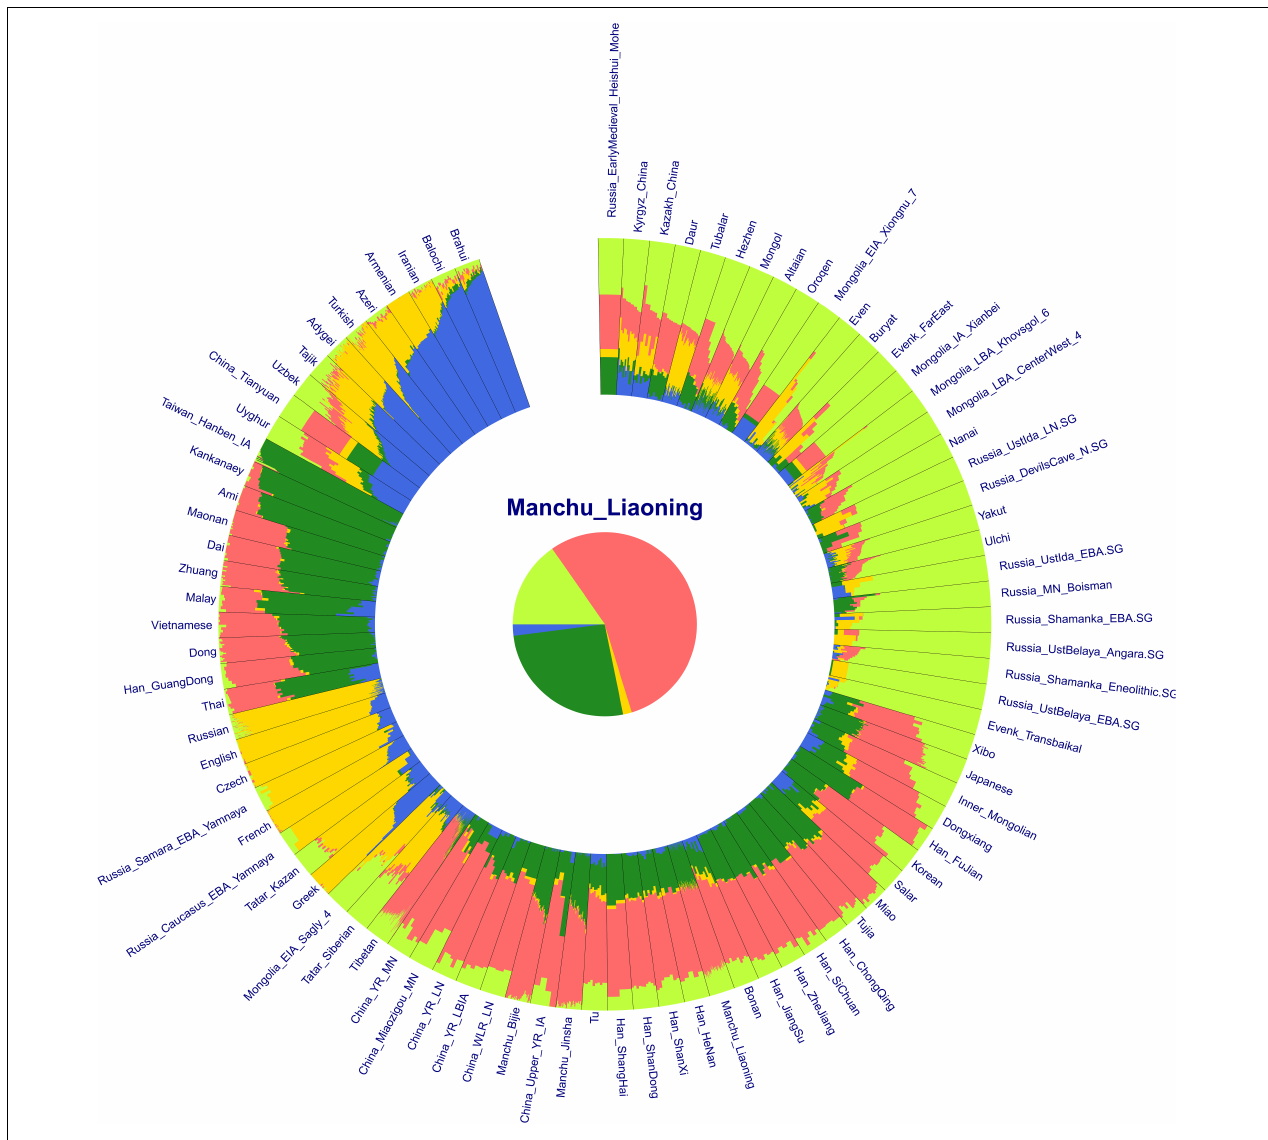
FIGURE 3 | Results of model-based ADMIXTURE clustering analysis. Clustering patterns were visualized with the predefined ancestral sources at K = 5. All of these ancestral components were revealed by different